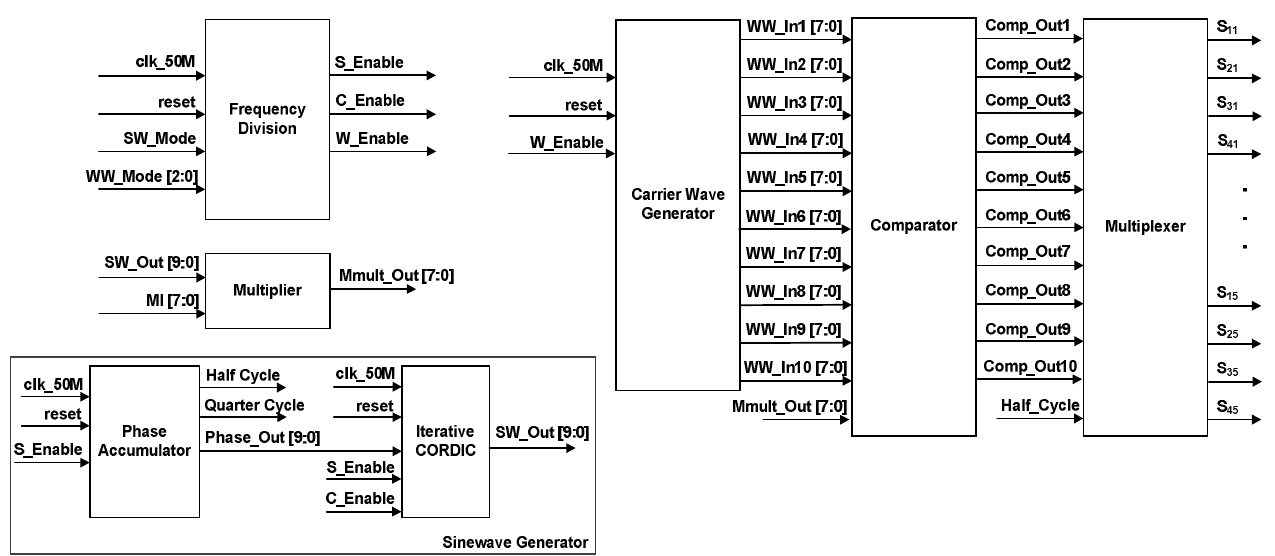
Figure 10. Top level of the SPWM digital switching controller.